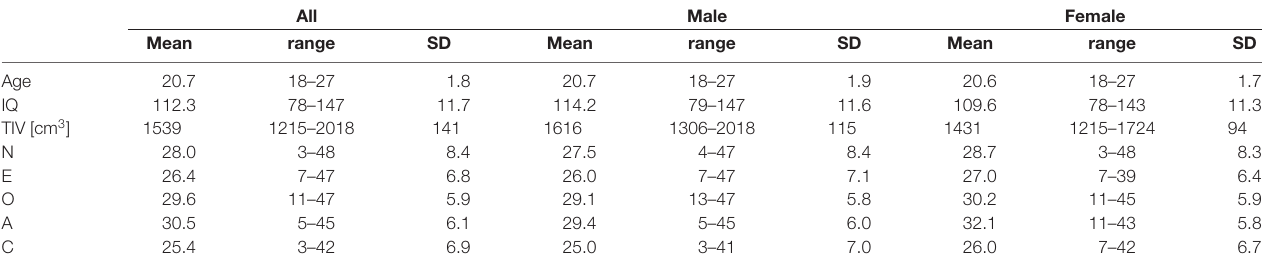
TABLE 1 | The mean, range and standard deviation (SD) of age, intelligence quotient (IQ), TIV and NEO Five-Factor Inventory (NEO-FFI) score in male group, female group and mixed gender group.